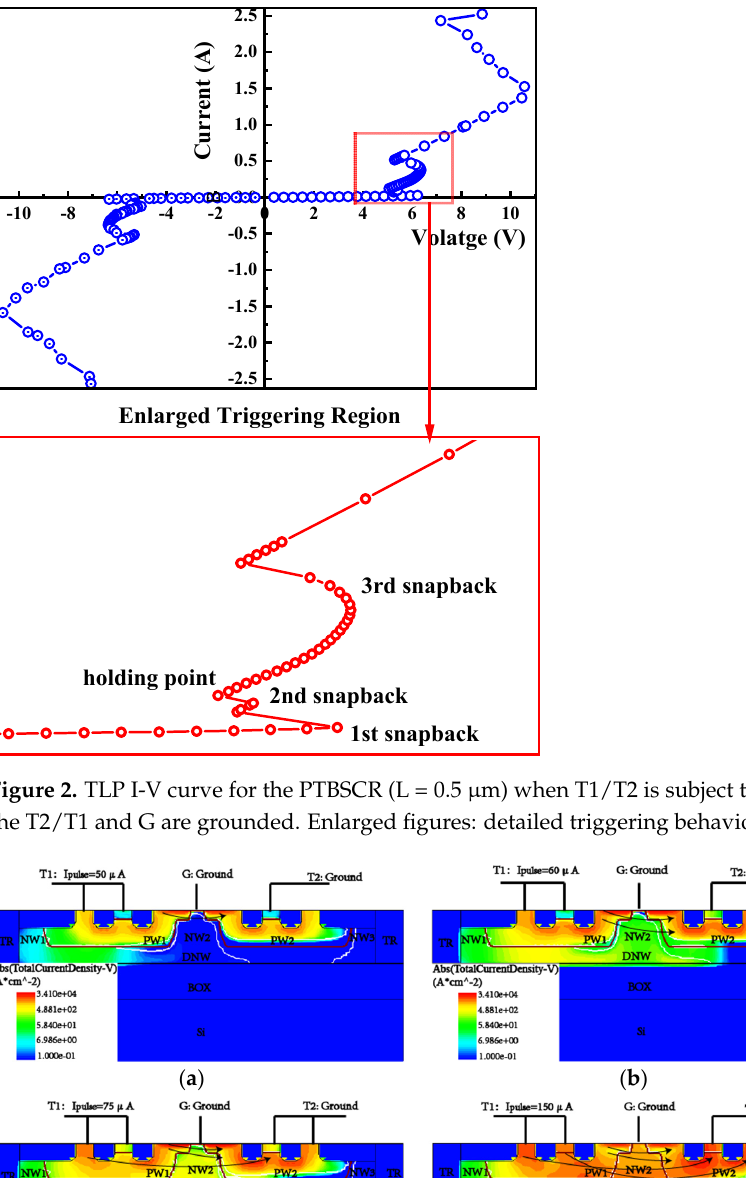
Figure 4. TCAD-simulated impact ionization rate distribution in PTBSCR (L = 0.5 μ m) when T1 is subject to the stress of I pulse = 60 μ A, T2 and G are grounded. The physical failure analysis (PFA) was carried out after the TLP test. Three metal layers have been removed to locate the failure spots. As shown in Figure 5, the failure spots caused by silicon melting appear in the junctions of the NW2/PW2 and N1+/PW1. As shown in Figure 4, the electric field at the reverse-biased NW2/PW2 junction is larger than other positions (impact ionization is related to the electric field), and the current al- most flows through these reverse-biased PN junctions, as shown in Figure 3d. The heat generated at the reverse-biased junction is the product of high-voltage dropping on the junction and a high ESD current, which causes temperature rises until silicon melting. The distributions of failure spots have indirectly verified the accuracy of simulated results in Figures 3 and 4.